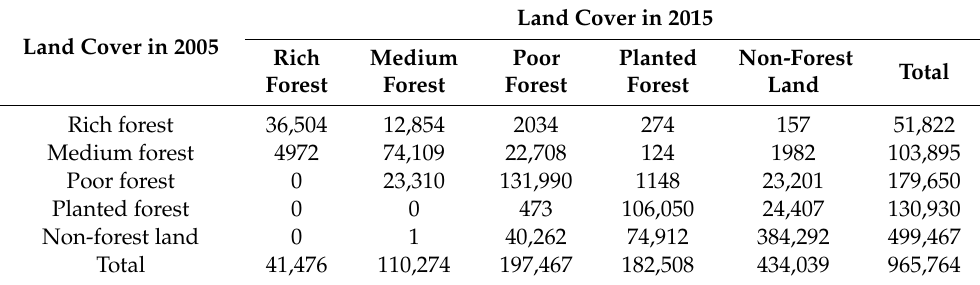
Figure 3. Change of forest land cover on different types of forest from ( a ) 2005 to ( b ) 2015. Table 5. Land cover transition matrix from 2005 to 2015 (ha) for the two provinces.